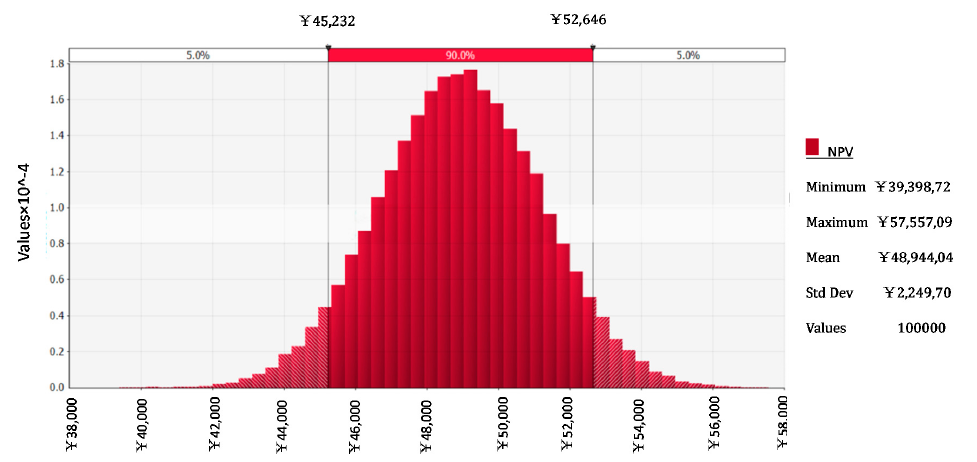
Figure 6. Impact of operating costs on NPV.